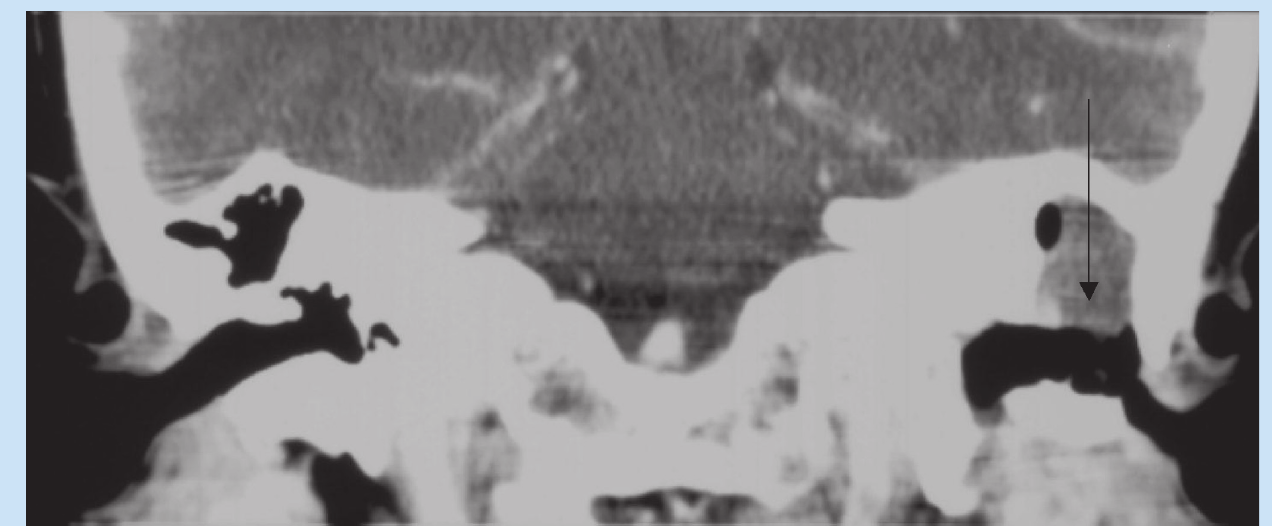
Fig. 1. Coronal CT using soft-tissue windowing, depicting a non-enhancing soft-tissue mass (arrow).